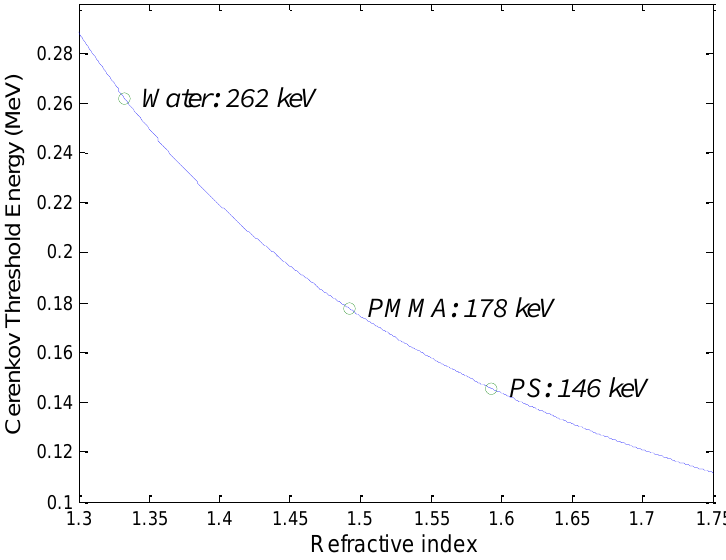
Figure 2. Cerenkov threshold energies of electrons according to refractive